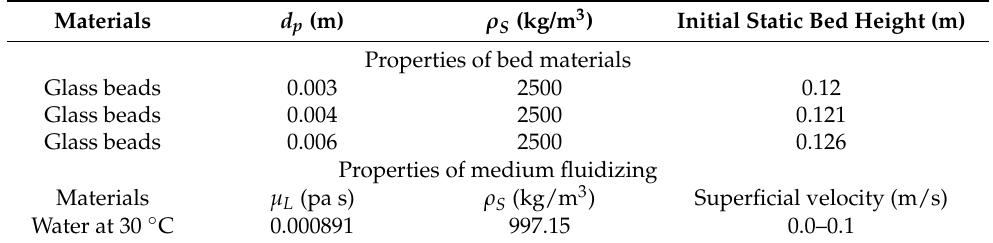
Table 2. The experimental data used in this investigation.